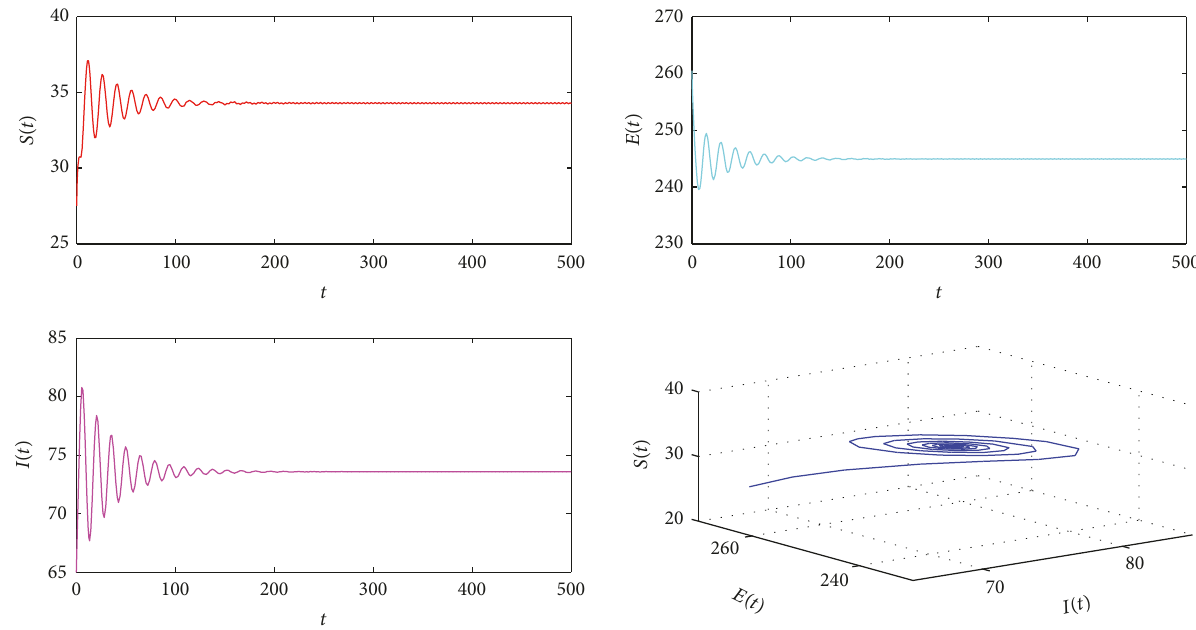
Figure 1: 𝑃 ∗ is locally asymptotically stable for 𝜏 = 4.475 < 𝜏 0 = 5.1686 with initial values “27.5, 260.5,